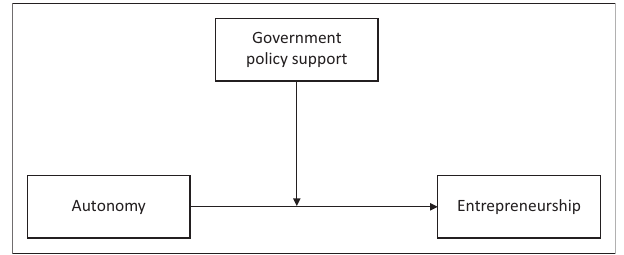
FIGURE 1: Conceptual